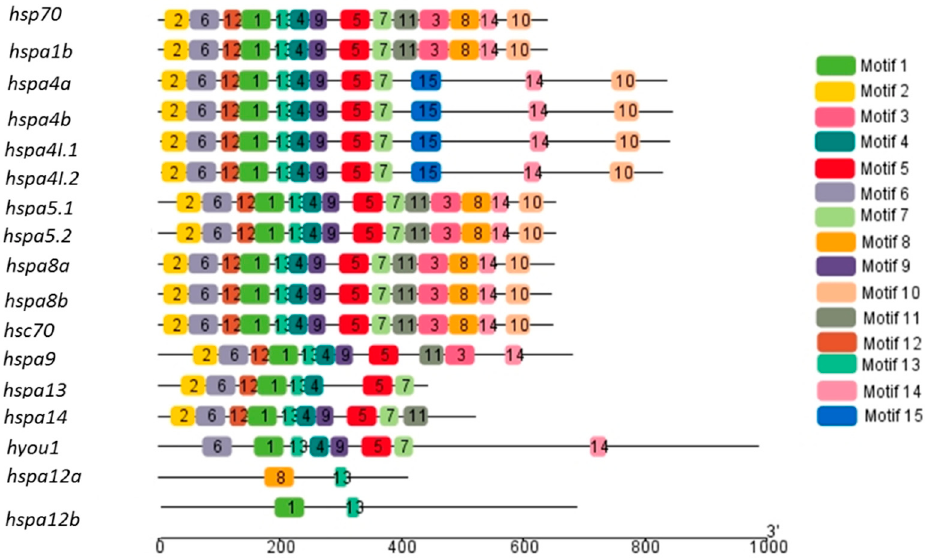
Figure 3. Distribution of conserved motifs in hsp70 of the large yellow croaker. Each colored box represents a putative motif detected in the protein sequence.